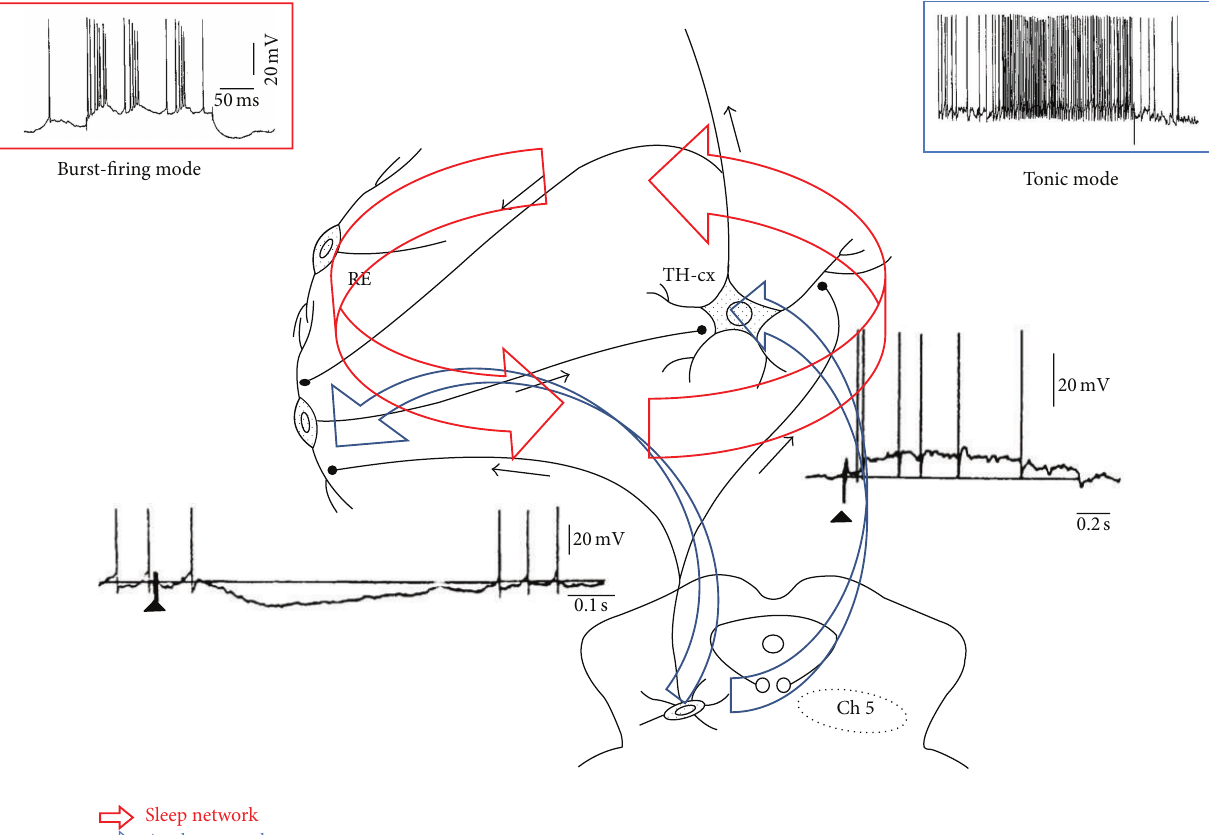
Figure 3: The thalamocortical system and its brainstem connections contain two antagonistic loops: one is responsible for the suppression- burst firing (red insert), and intrathalamic circuit connecting reticular inhibitory nuclei with thalamocortical relay neurons producing spindles and slow waves (sleep network); the other system is the ascending reticular system and thalamic connections (blue) conveying cholinergic arousal influences and inhibiting the reticular nuclei providing tonic thalamocortical neuronal discharge flow (blue upper insert), maintaining wake state. The right lower insert shows the excitatory postsynaptic effect of ascending cholinergic reticular neurons on the thalamocortical relay cell. The left lower insert shows the inhibitory postsynaptic effect of the cholinergic ascending arousal neurons on the thalamic reticular neurons (composed after Steriade [45], and Itier and Bertrand